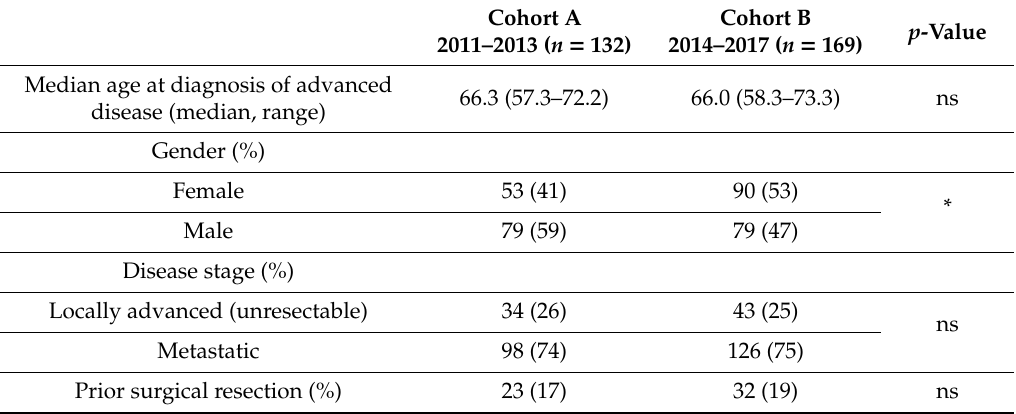
Table 1. Patient Characteristics of patients and tumors of the two main study